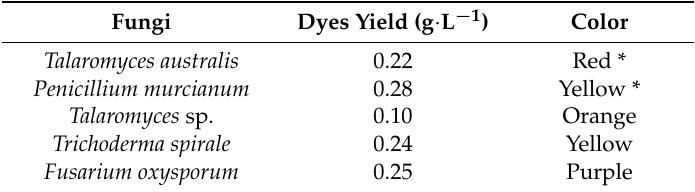
Table 2. Yield and color of dyes produced in liquid media by fungi isolated from rotten wood